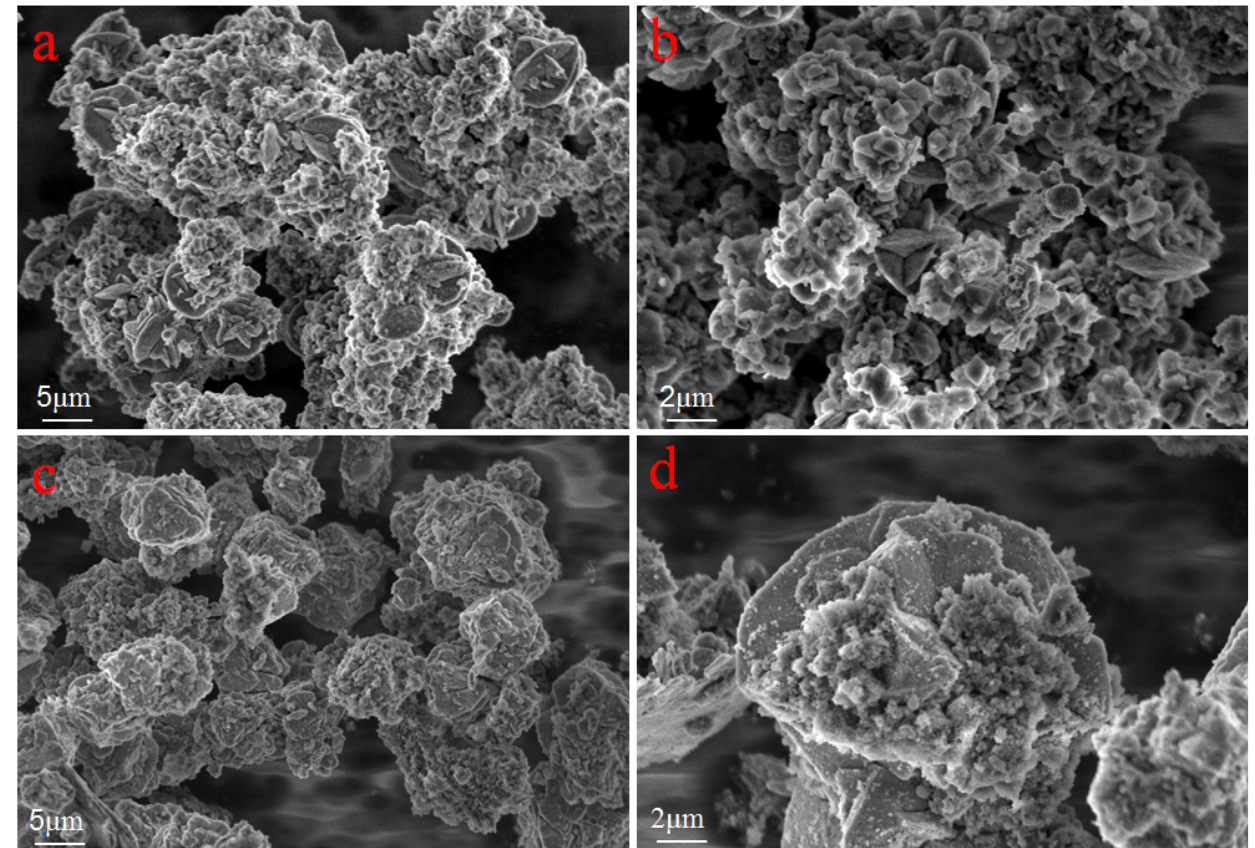
Figure 2. SEM images of ( a , b ) ZMA and ( c , d ) alkali activation product. FTIR analysis of illite and synthesized Y-type zeolite were performed separately as shown in Figure 3. The FTIR spectrum of ZMA with the peak located at 454 cm − 1 indicates the T-O-T bending vibration (T = Si/Al). The peak at 690 cm − 1 (743 cm − 1 ) indicates the internal (external) T-O-T (T = Si/Al) symmetric vibration of the synthetic zeolite [34], and the peak at 990 cm − 1 (1467 cm − 1 ) is the internal (external) T-O-T (T = Si/Al) asymmetric vibration [35–38]. The two peaks located at 672 and 610 cm − 1 are double-ring vibrations, indicating the presence of zeolites with double-ring structures [39]. The peaks at 1648 and 3475 cm − 1 are bending and stretching vibrations of the O-H group [40], with the strong and broad peak at 3475 cm − 1 , while the peak at 1648 cm − 1 is associated with water molecules adsorbed in the cavity of the molecular sieve [41]. It can be noted that these two peaks, located at 539 and 467 cm − 1 in the characteristic mapping of illite, do not appear in the mapping of ZMA, which represent the Si-O-Al groups in the clay structure [42]. There was no peak of 781~800 cm − 1 in ZMA which represents Si-O-Si of quartz [43]. The